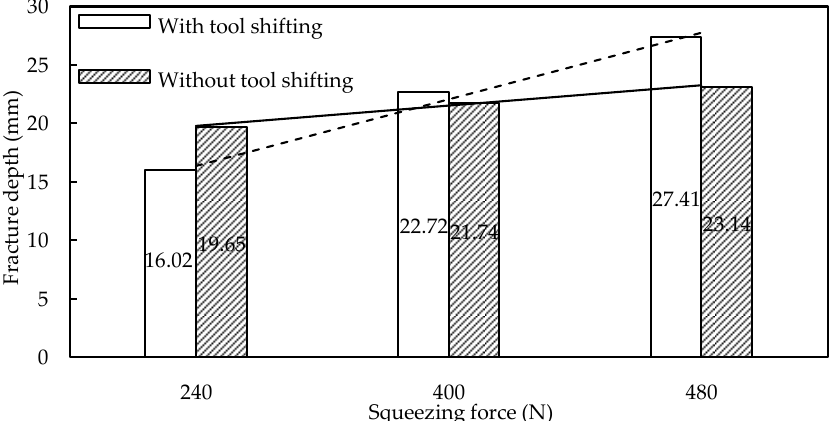
Figure 7. Influence of slave tool shift on DSIF formability (reprinted with permission from B. Lu et al. [38], Copyright 2015 Elsevier).